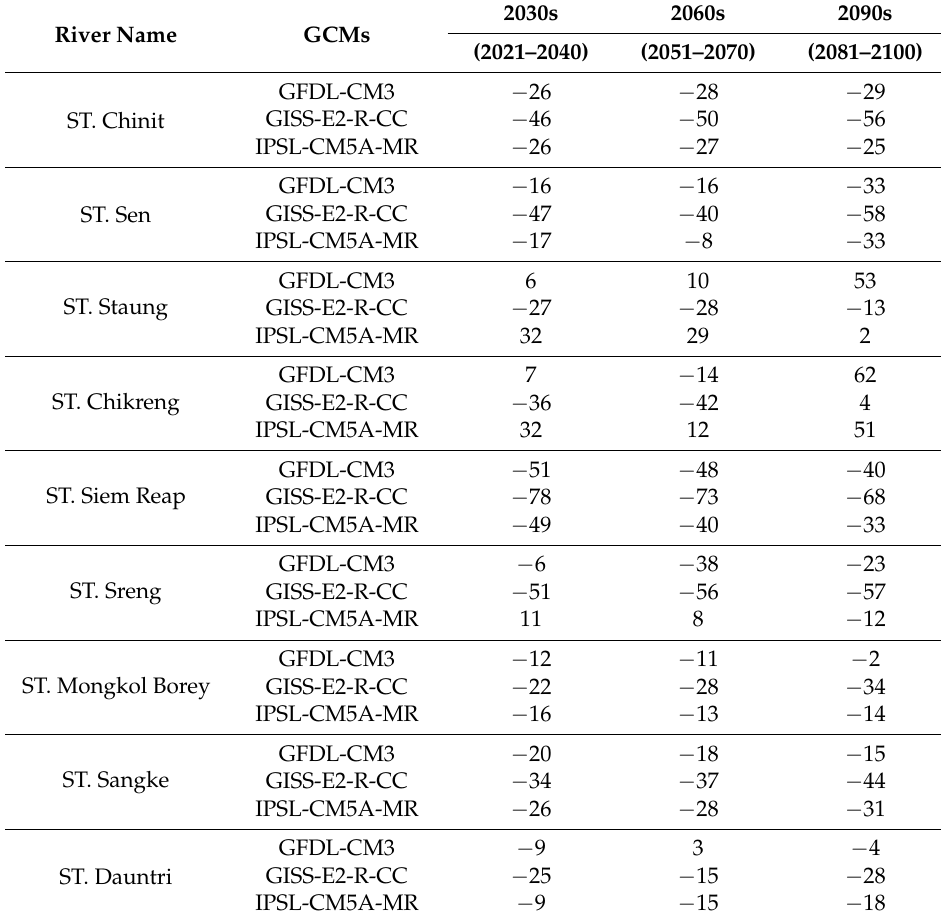
Table 5. Percentage changes in the mean annual flows for different climate scenarios, compared with baseline